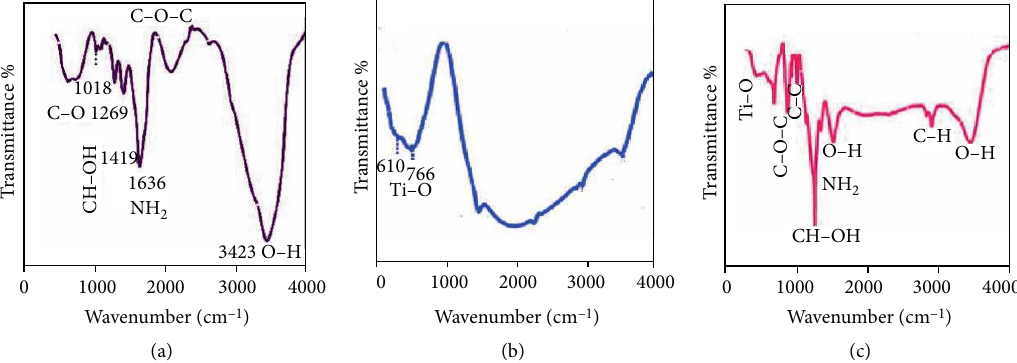
Figure 6: FTIR analysis of prepared nanomaterials. (a) Chitosan NPs, (b) TiO